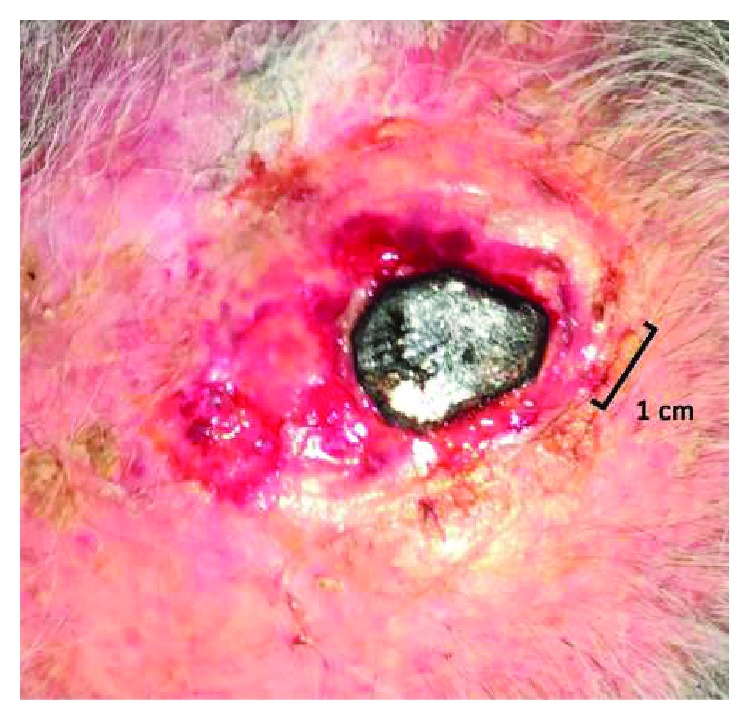
Eschar detached.